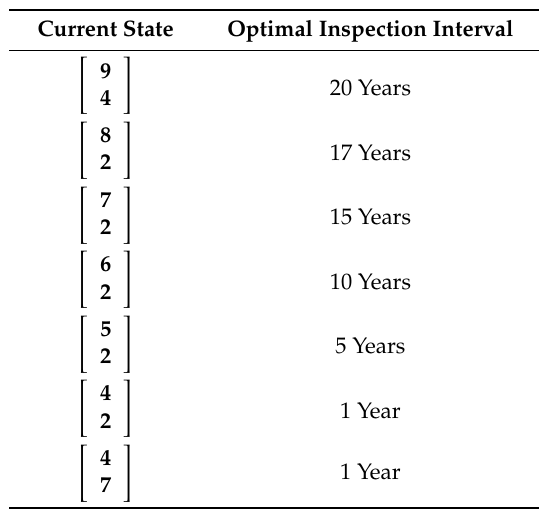
Table 5. Optimal inspection intervals for 5% risk